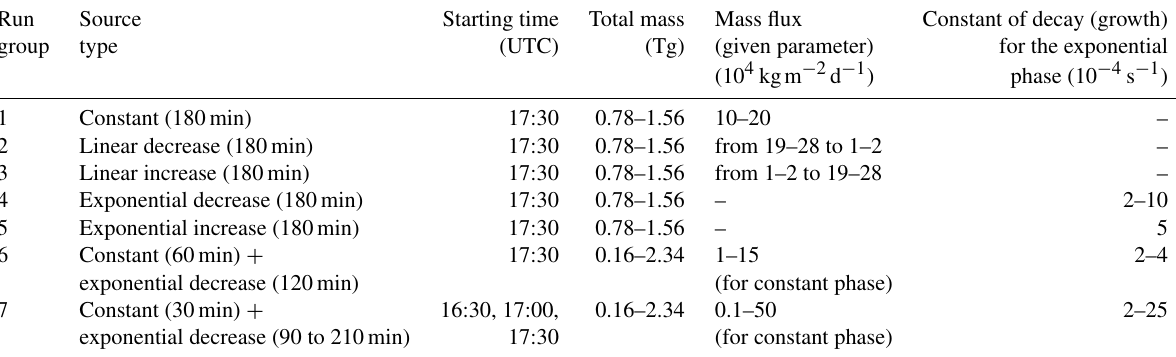
Table 3. Source term settings used in the different groups of simulations. Table shows the considered ranges for eruption starting time, total CO 2 emitted mass, CO 2 mass flux, and constant of decay (or growth) for the exponential